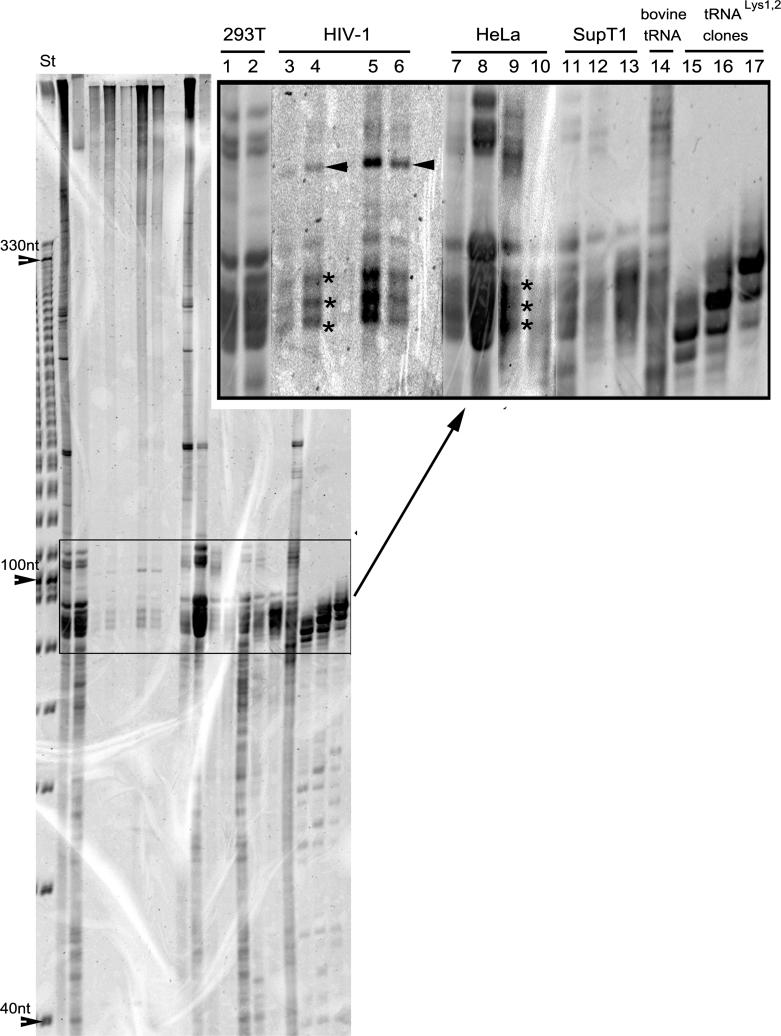
Profile of Small RNA Species Incorporated into HIV-1 ParticlesTotal and small RNA were obtained from cells and purified virions, and analyzed onto a long (50 cm) 15% denaturing PAGE followed by SYBR Gold staining. There was a 10-bp DNA ladder (lane St), 2.3-μg total 293T RNA (lane 1), 1.5-μg small 293T RNA (lane 2), purified HIV-1 virion RNA (169 ng and 338 ng) (lanes 3 and 4, respectively), purified RNA from HIV-1 virions not containing the viral genome (472 ng and 236 ng) (lanes 5 and 6, respectively), 2.7-μg total HeLa RNA (lane 7), 2.4-μg small HeLa RNA (lane 8), 100-ng 60S NA fraction from HeLa cells (lane 9), 100-ng Fr2 from HeLa cells (lane 10), 0.9-μg SupT1 small RNA (lane 11), 200-ng 60S NA fraction from SupT1 cells (lane 12), 200-ng Fr2 from SupT1 cells (lane 13), 1.5-μg bovine tRNA (lane 14), 200-ng tRNALys1,2 size G2 RNA + C tail (see Table S2) (lane 15), 200-ng tRNALys1,2 size G2 RNA + CC tail (lane 16), and 200-ng tRNALys1,2 size G2 RNA + CCA tail (lane 17). Asterisks indicate positions of similar size bands in different lanes. Arrows indicate small RNAs specifically enriched in purified virions. The contrast in lanes 3 to 6 in the magnified rectangle has been artificially increased to help in visualizing bands.